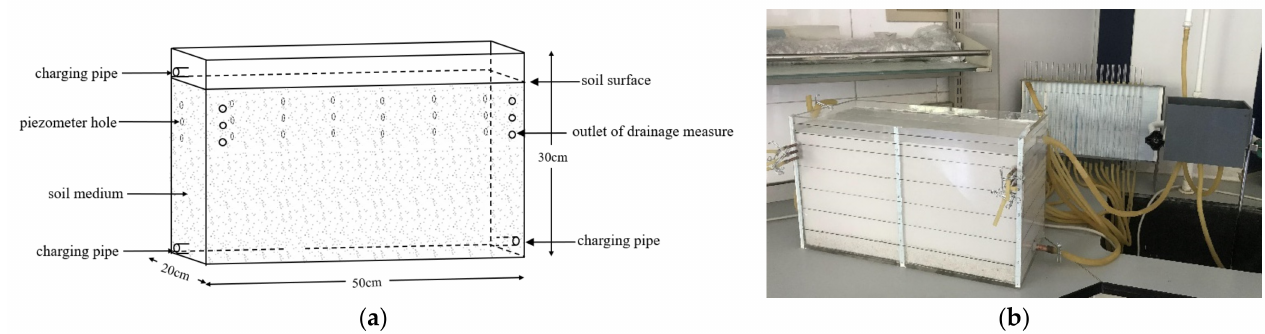
Figure 1. Schematic diagram of the test device, ( a ) Three-dimensional view of sand tank; ( b ) The physical model of drainage.